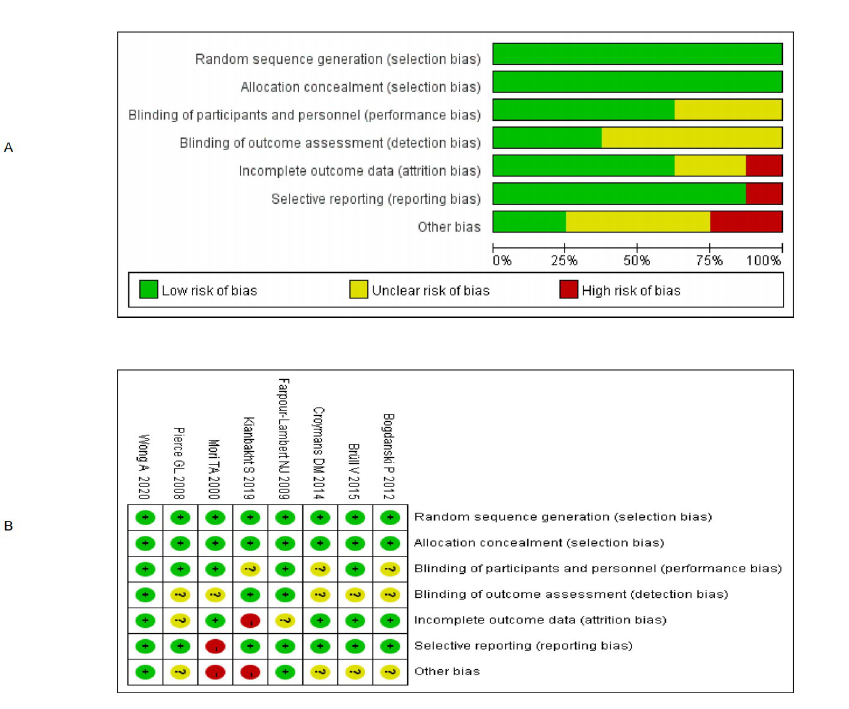
Fig 2. Bias risk charts for the included studies.